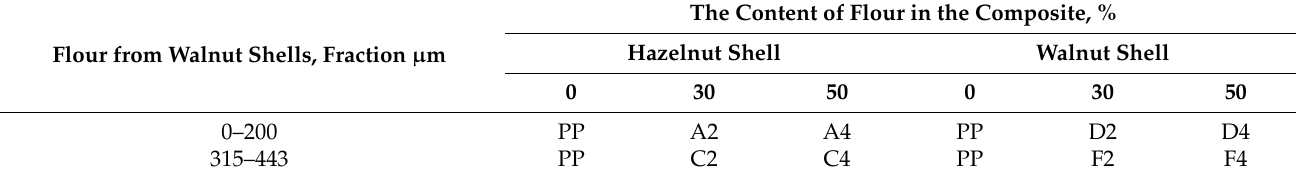
Table 1. Marking of the investigated materials.